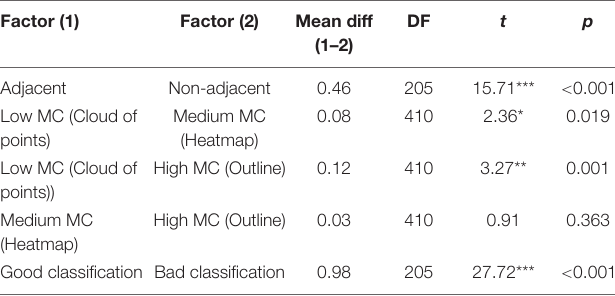
TABLE 2 | Post hoc comparisons adjacency, MC, and classification on